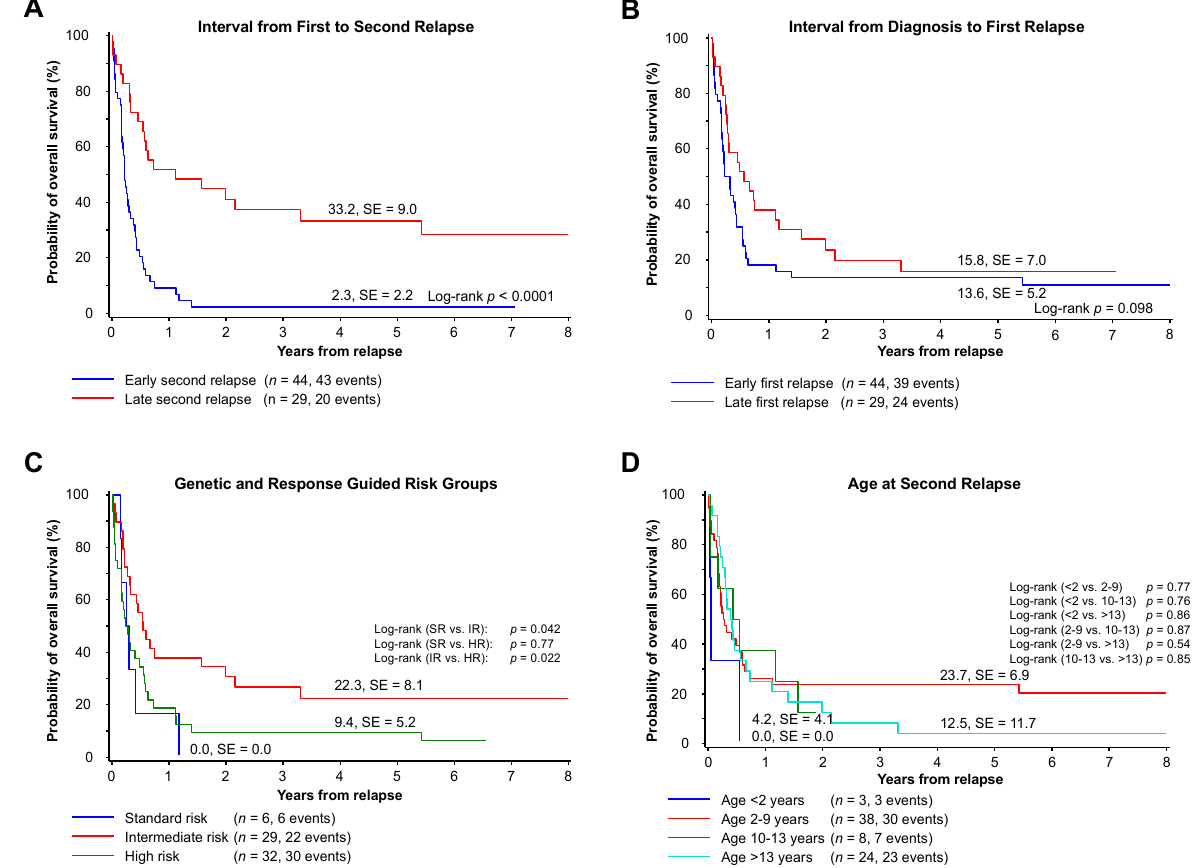
Figure 3. Prognostic factors. ( A ) Five-year overall survival of patients with early or late second relapse defined as relapse within or after one year after first relapse. ( B ) Five-year overall survival of patients with preceding early or late first relapse, defined as first relapse within or after one year after initial diagnosis. ( C ) Five-year overall survival of patients grouped by genetically and response-guided defined risk groups at initial disease. ( D ) Five-year overall survival of patients grouped by age at second relapse.